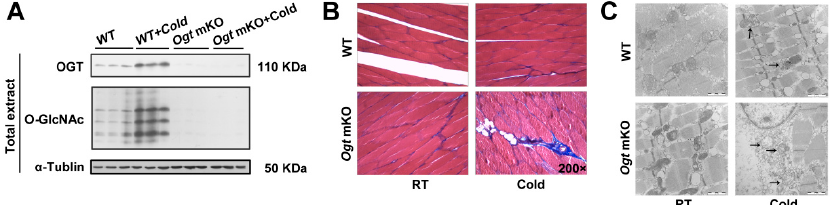
Figure 1. OGT mKO exacerbated CS-induced SM and mitochondrial damage. ( A ) Western blotting analysis using antibodies against OGT and O-GlcNAc. Tubulin served as a loading control. Expression of autophagy-related proteins in SM total extract and mitophagy-related proteins in mitochondrial extract. After CS treatment, fresh SM tissues of four groups (WT group, WT + cold group, Ogt mKO group, Ogt mKO + cold group) were collected, sectioned, and stained with ( B ) Masson’s trichrome and ( C ) Mouse SM tissue was sliced into ultrathin sections and observed under a transmission electron microscope. The arrows represent damaged mitochondria.